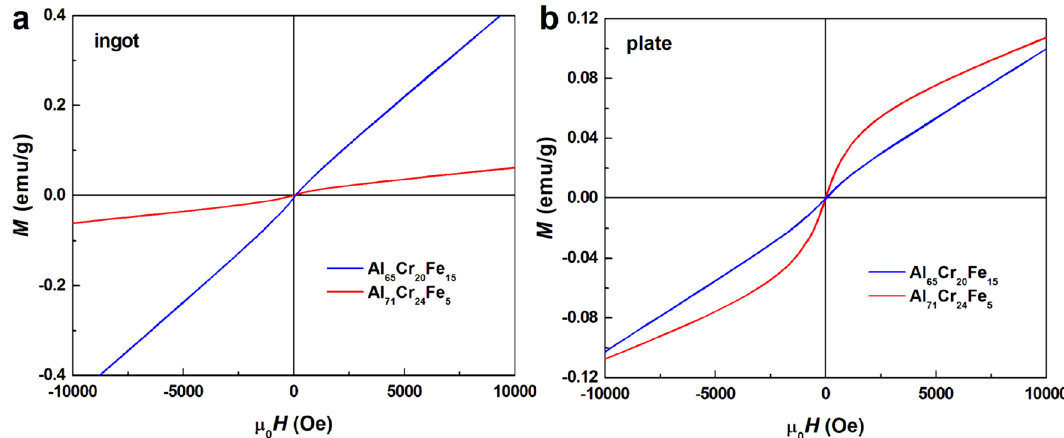
Figure 9. Magnetization (M) as a function of the magnetic field (µ 0 H) at room temperature for Al 65 Cr 20 Fe 15 and Al 71 Cr 24 Fe 5 alloys in a form of ingots ( a ) and plates ( b ).